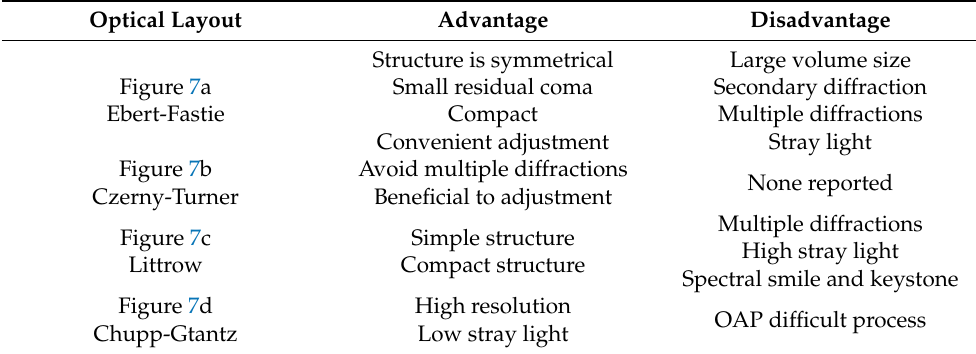
Table 1. Comparison of advantages and disadvantages of various optical